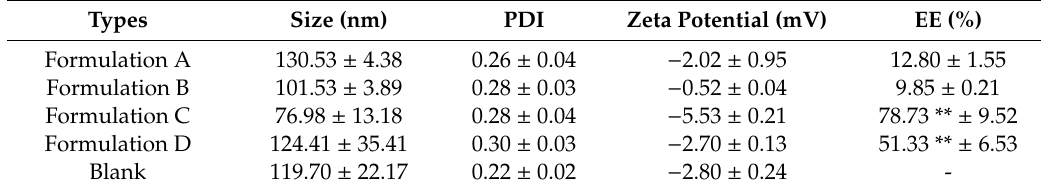
Table 2. Characteristics of obtained malB-loaded